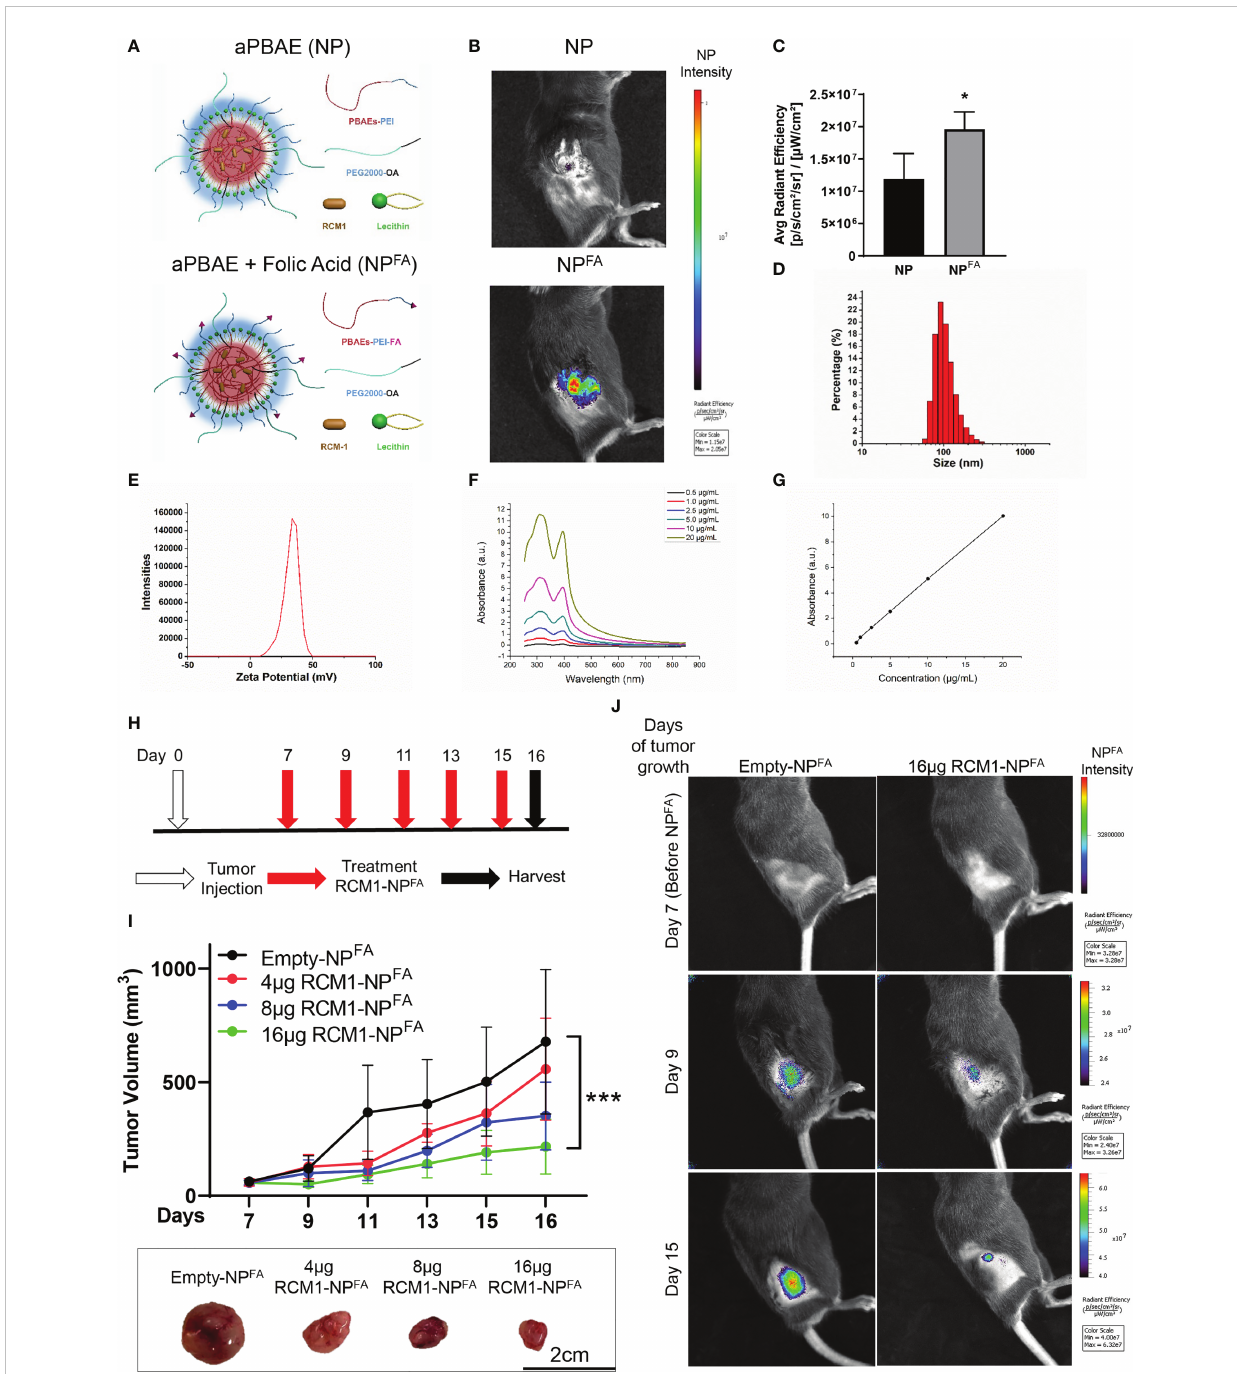
FIGURE 3 Generation of nanoparticle to deliver RCM1 to tumors. (A) , Graphic of amphiphilic poly-beta amino ester (aPBAE) nanoparticles without folic acid (NP, top) and with folic acid (NP FA , bottom). (B) , Highly ef fi cient delivery of NP FA , compared to NP into the tumors is shown using IVIS imaging. Mice bearing Rd76-9 subcutaneous RMS tumors were injected with NP or NP FA labeled with DyLight 800. NP FA are present in the tumor 48 hours after i.v. injection. (C) , Average radiant ef fi ciency indicating NP FA have a higher intensity compared to NP. (D) , The sizes of NP FA were measured and the hydrodynamic average diameter of NP FA is 160.67nm. (E) , The surface charge of NP FA is 38.13mV. (F) , The UV/Vis spectrum for RCM1 at increasing concentrations in DMSO determined RCM1 has an absorbance peak at 310nm and 395nm. (G) , Data from the UV/VIS spectra was used to generate a standard concentration curve that was used to determine RCM1 concentration in the nanoparticles. Adjusted R 2 = 0.99944. (H) , Schematic diagram showing treatment strategy of tumor bearing mice. Rhabdomyosarcoma Rd76-9 cells were inoculated subcutaneously. Animals were treated with 4µg, 8µg, or 16µg RCM1- NP FA . (I) , Treatment with RCM1-NP FA reduced tumor burden in a dose-dependent manner in animals. Mice were treated with 4µg, 8µg, or 16µg of RCM1-NP FA or with empty-NP FA . Tumor volumes were measured at different time points compared to empty-NP FA (top panel). Representative tumors per group are shown (bottom panel). Values are shown as mean ± SD. n=3-7, * P <0.05; *** P <0.001. (J) , Presence of Empty-NP FA and RCM1-NP FA nanoparticles in the tumors are shown at days 9 and 15 after treatment. Nanoparticles were labeled with DyLight 800 and visualized using